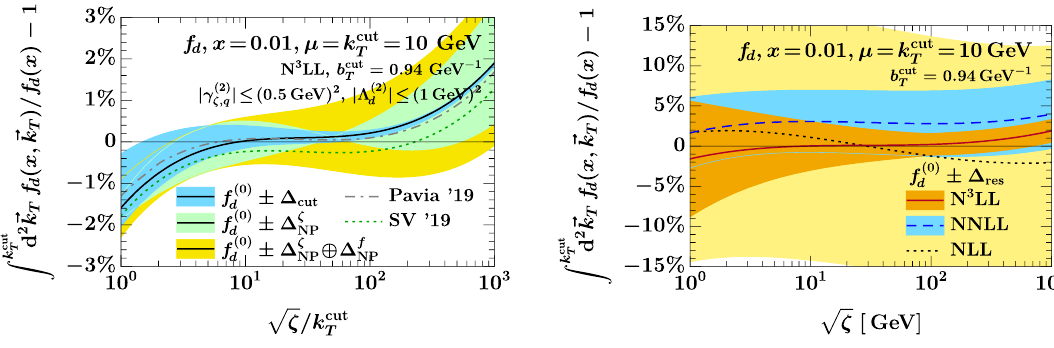
Figure 9 . The normalized deviation of the transverse-momentum integral of the TMD PDF from √ the collinear PDF as a function of the evolution scale ζ . We also include the SV and Pavia global fits in the left panel. We approximate the transverse-momentum integral of the TMD PDF with K (3) [ f (0) ] , which is purely perturbative. In both figures, we use fixed µ = k cut = 10 GeV and T i x = 0 . 01 , and the TMD PDF is for a down quark. See figure 15 in appendix B for the results for other light quark flavors including u, ¯ d, ¯ u , and s .